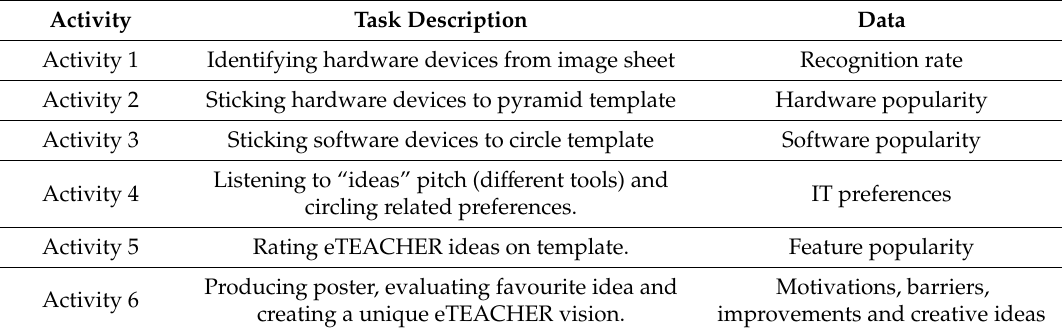
Table 5. Workshop Ask activity